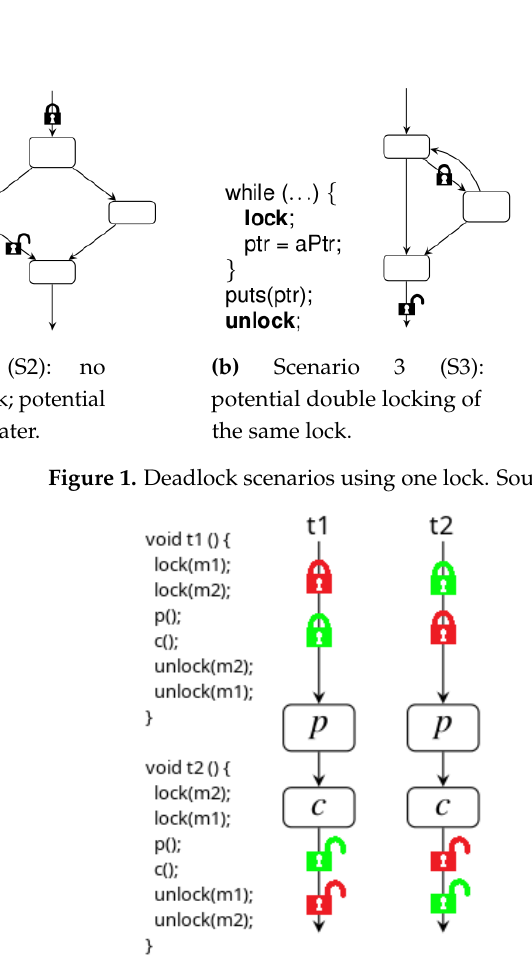
Figure 2. Scenario 1 (S1): deadlocks due to mutually exclusive locking